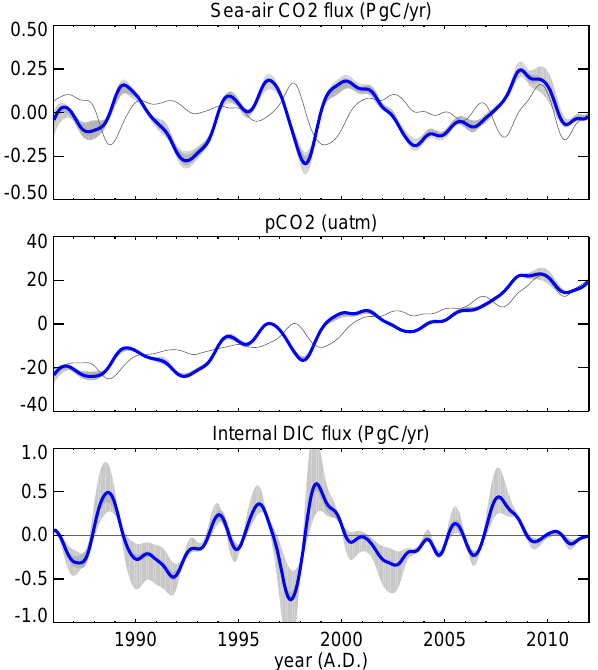
Fig. 5. Interannual carbon anomalies in the tropical Pacific (15 ◦ S– Figure 5. Interannual carbon anomalies in the tropical Pacific 15 ◦ N) from run SFC (blue; filter, grey uncertainty band, and sign (15 ◦ S–15 ◦ N) from run SFC (blue; filter, grey uncertainty band, ), convention as in Fig. 3): Top: Sea–air CO 2 flux anomalies ( f CO 2 ma and sign convention as in Fig. 3). Top: sea–air CO 2 flux anomalies middle: surface CO 2 partial pressure anomalies ( p CO 2 ), bottom: ( f CO 2 ma ). Middle: surface CO 2 partial pressure anomalies ( p CO 2 ). anomalies in the ocean-internal DIC sources and sinks ( f DIC , note int Bottom: anomalies in the ocean-internal DIC sources and sinks vertical scale different from f CO 2 ). The dark grey lines give the ma ( f DIC , note that the vertical scale is different from f CO 2 ma ). The dark int a-priori state of the diagnostic scheme only responding to changes grey lines give the a priori state of the diagnostic scheme, which in the driving variables (predominantly temperature). only responds to changes in the driving variables (predominantly